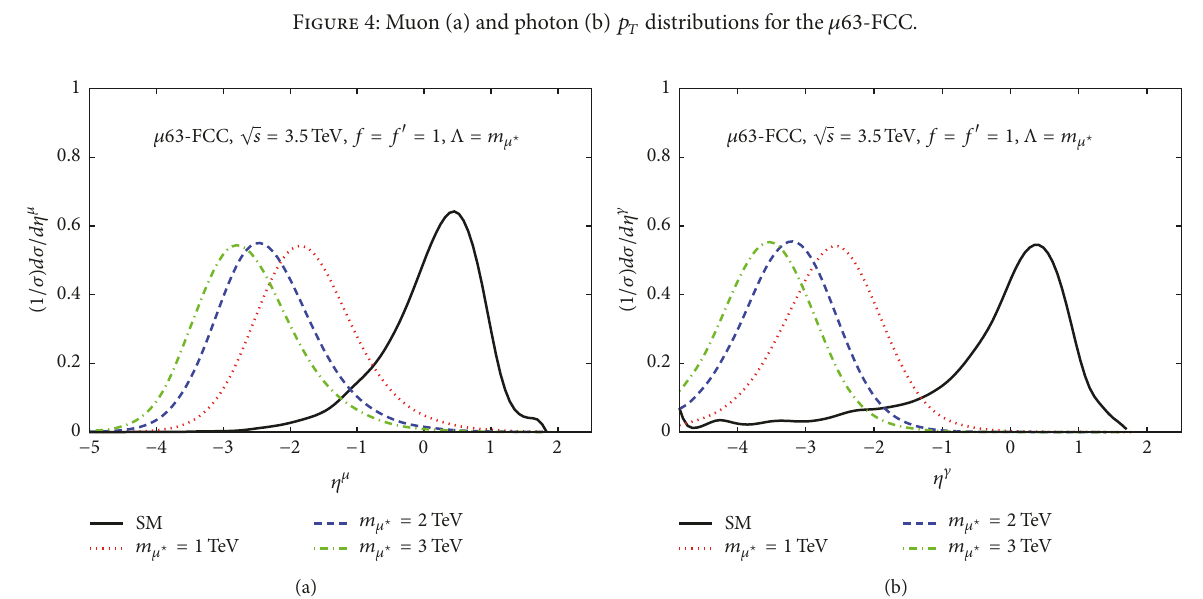
Figure 5: Muon (a) and photon (b) normalized 𝜂 distributions for the 𝜇63